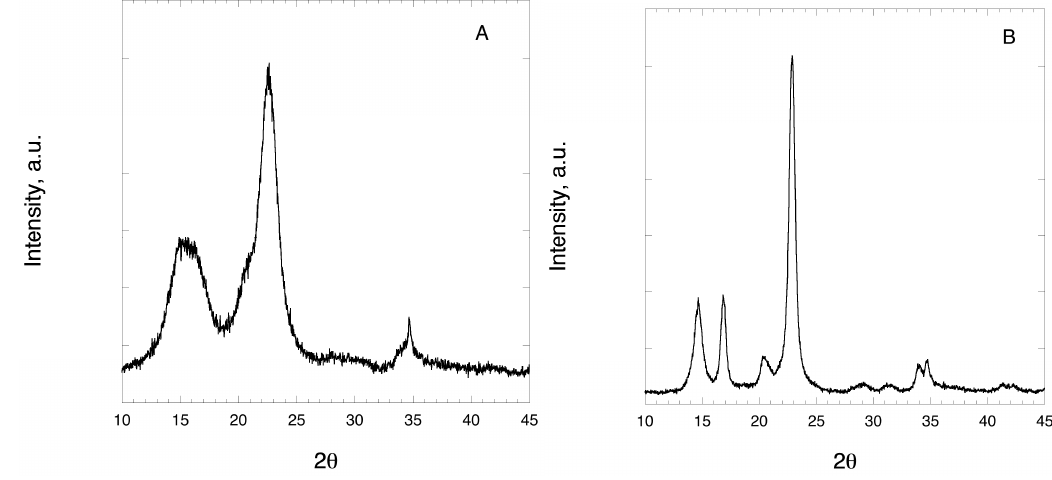
Figure A1. X-ray diffraction (XRD) profiles of pristine ( A ) MCC and ( B ) Figure A1. X-Ray diffraction (XRD) profiles of pristine ( A ) MCC and ( B ) CLAD. Table A1. Composition of biorelevant media as reported by manufacturer (Biorelevant Inc).